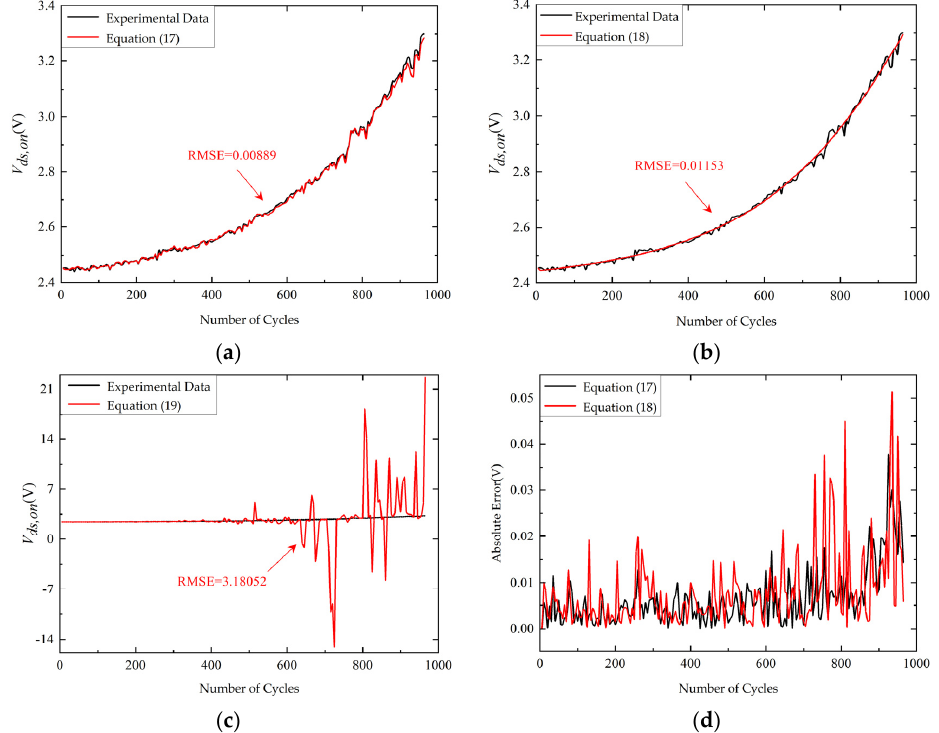
Figure 11. The prediction results of different degradation empirical models using PF. ( a ) The pre- diction curve based on the degradation model represented by Equation (19); ( b ) the prediction curve based on the degradation model represented by Equation (20); ( c ) the prediction curve based on the degradation model represented by Equation (21); ( d ) the absolute error of prediction curve based on the degradation model represented by Equation (19) and the prediction curve based on the deg- radation model represented by Equation (20).